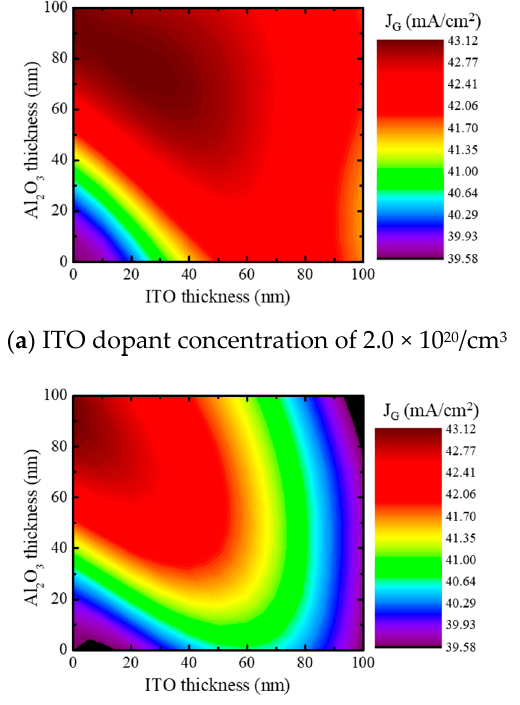
Figure 2. J G characteristics performed with the Al 2 O 3 /ITO/c-Si structure via OPAL 2 simulation. The dependence of J G on ITO dopant concentration and Al 2 O 3 thickness is shown. ITO dopant concentration: ( a ) 2.0 × 10 20 , ( b ) 4.9 × 10 20 , and ( c ) 6.1 × 10 20 / cm 3 .